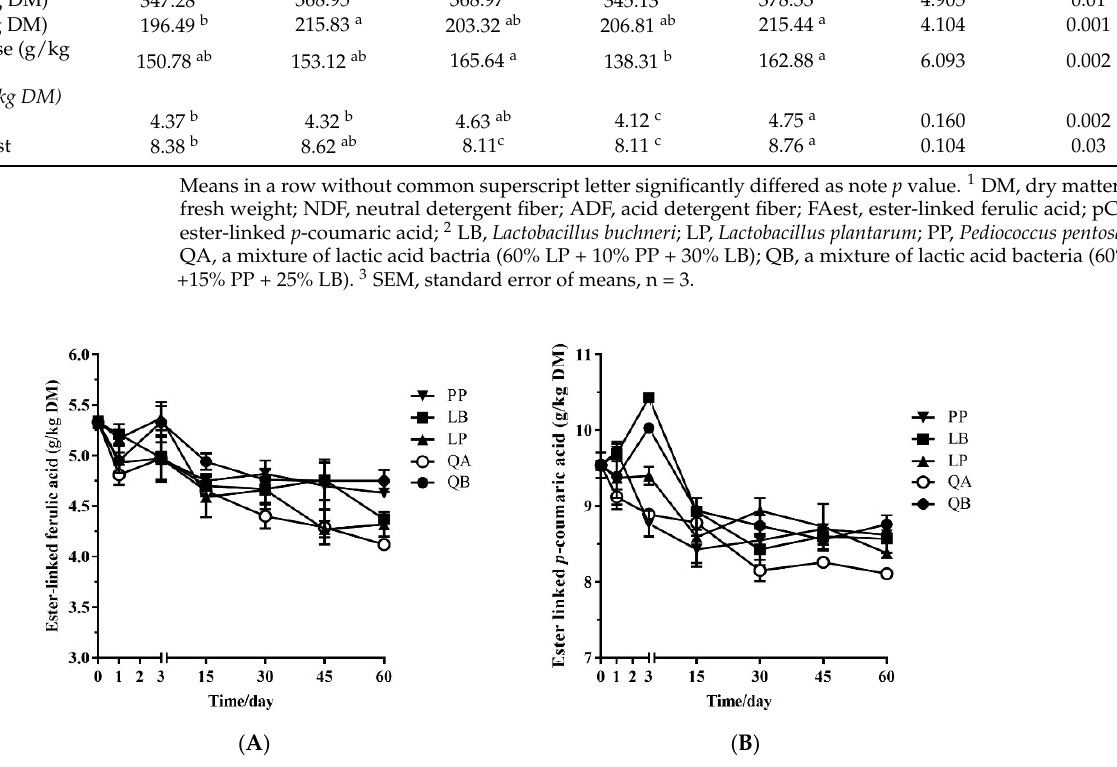
Figure 2. Effects of additive and ensiling time on ferulic acid and p-coumaric acid concentration of whole corn silage. ( A ) Dynamics of ester-linked ferulic acid; ( B ) Dynamics of ester-linked p-coumaric acid.